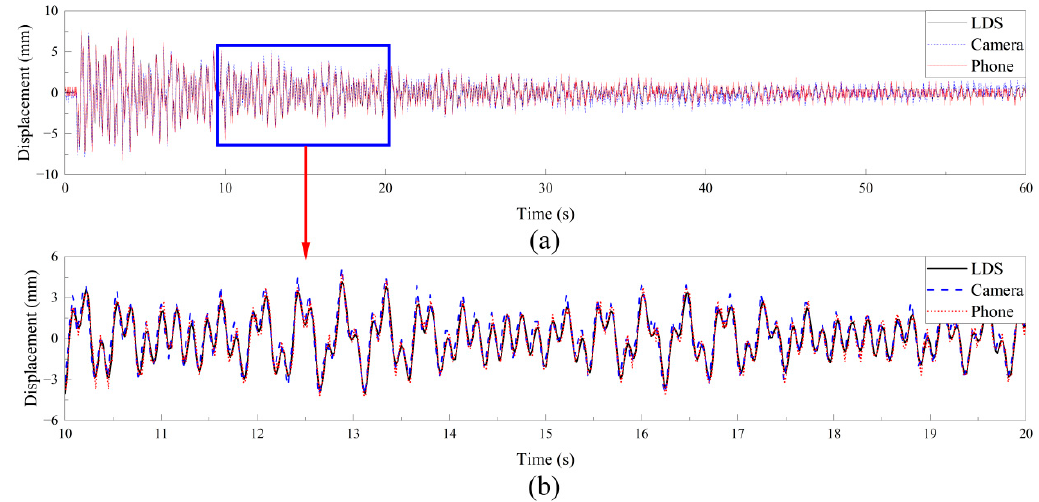
Figure 22. Time history comparison of vibration displacement in flap-wise direction: ( a ) Whole displacement time history; ( b ) 10~20 s displacement time history.